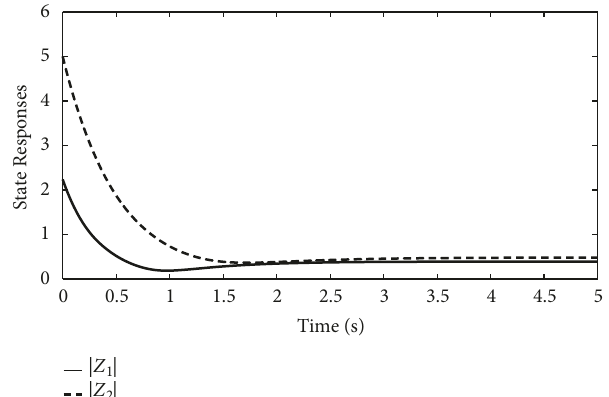
Figure 2: State module curves of (48) without stochastic term.